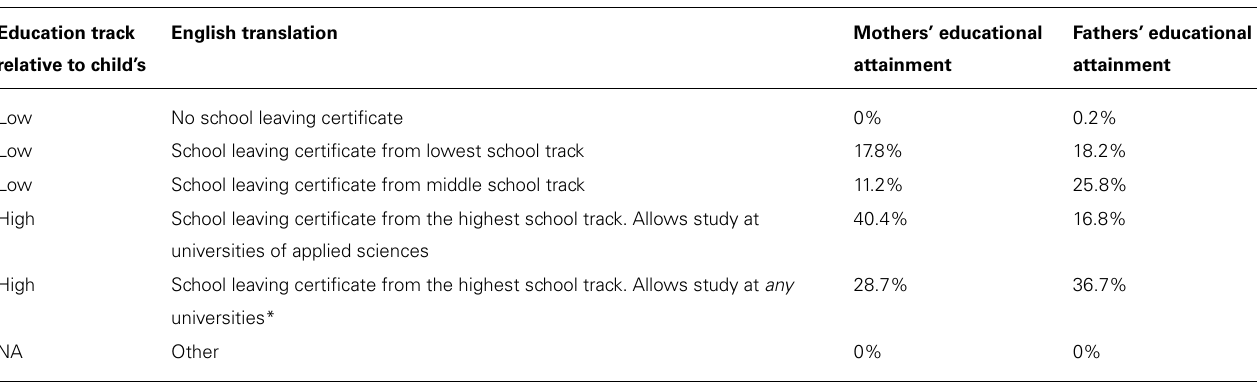
Table 1 | Classification of parents’ educational attainment in the present